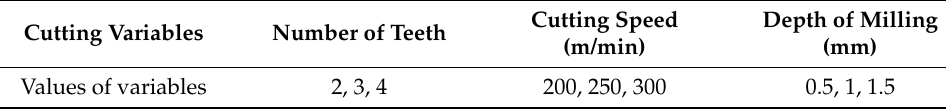
Table 3. Cutting variables and their